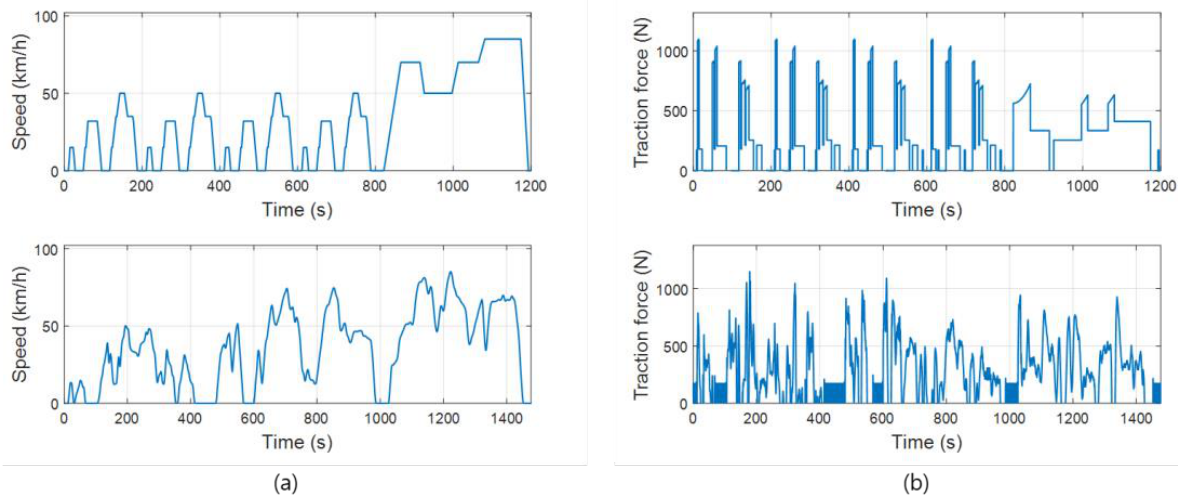
Figure 4. Driving cycles for the EMS design: ( a ) Driving cycle v v ; ( b ) Desired traction force F tract .